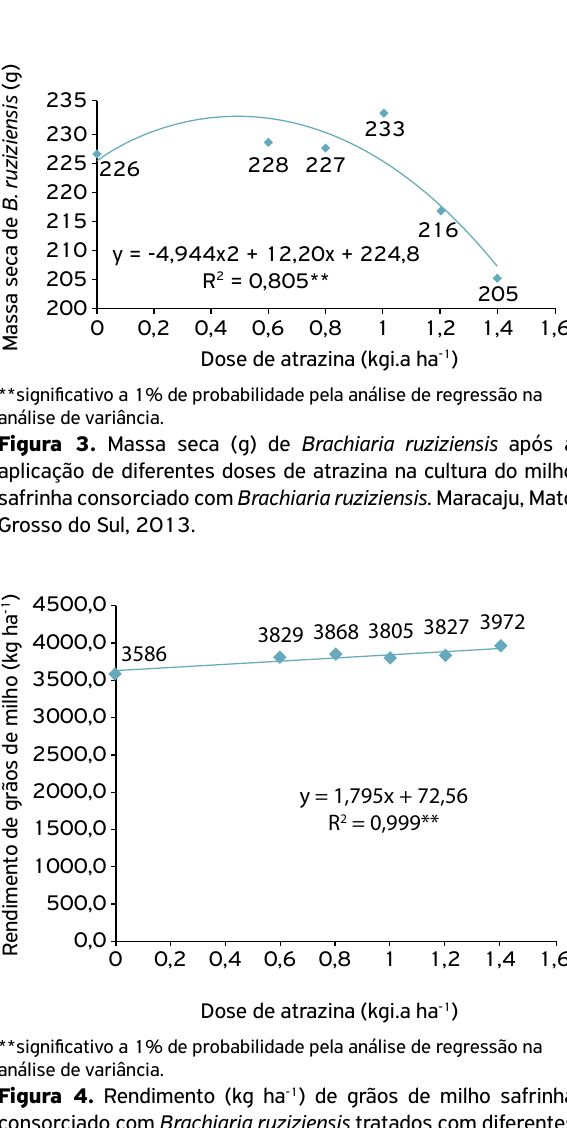
Figura 4. Rendimento (kg ha -1 ) de grãos de milho safrinha consorciado com Brachiaria ruziziensis tratados com diferentes doses de atrazina. Maracaju, Mato Grosso do Sul,